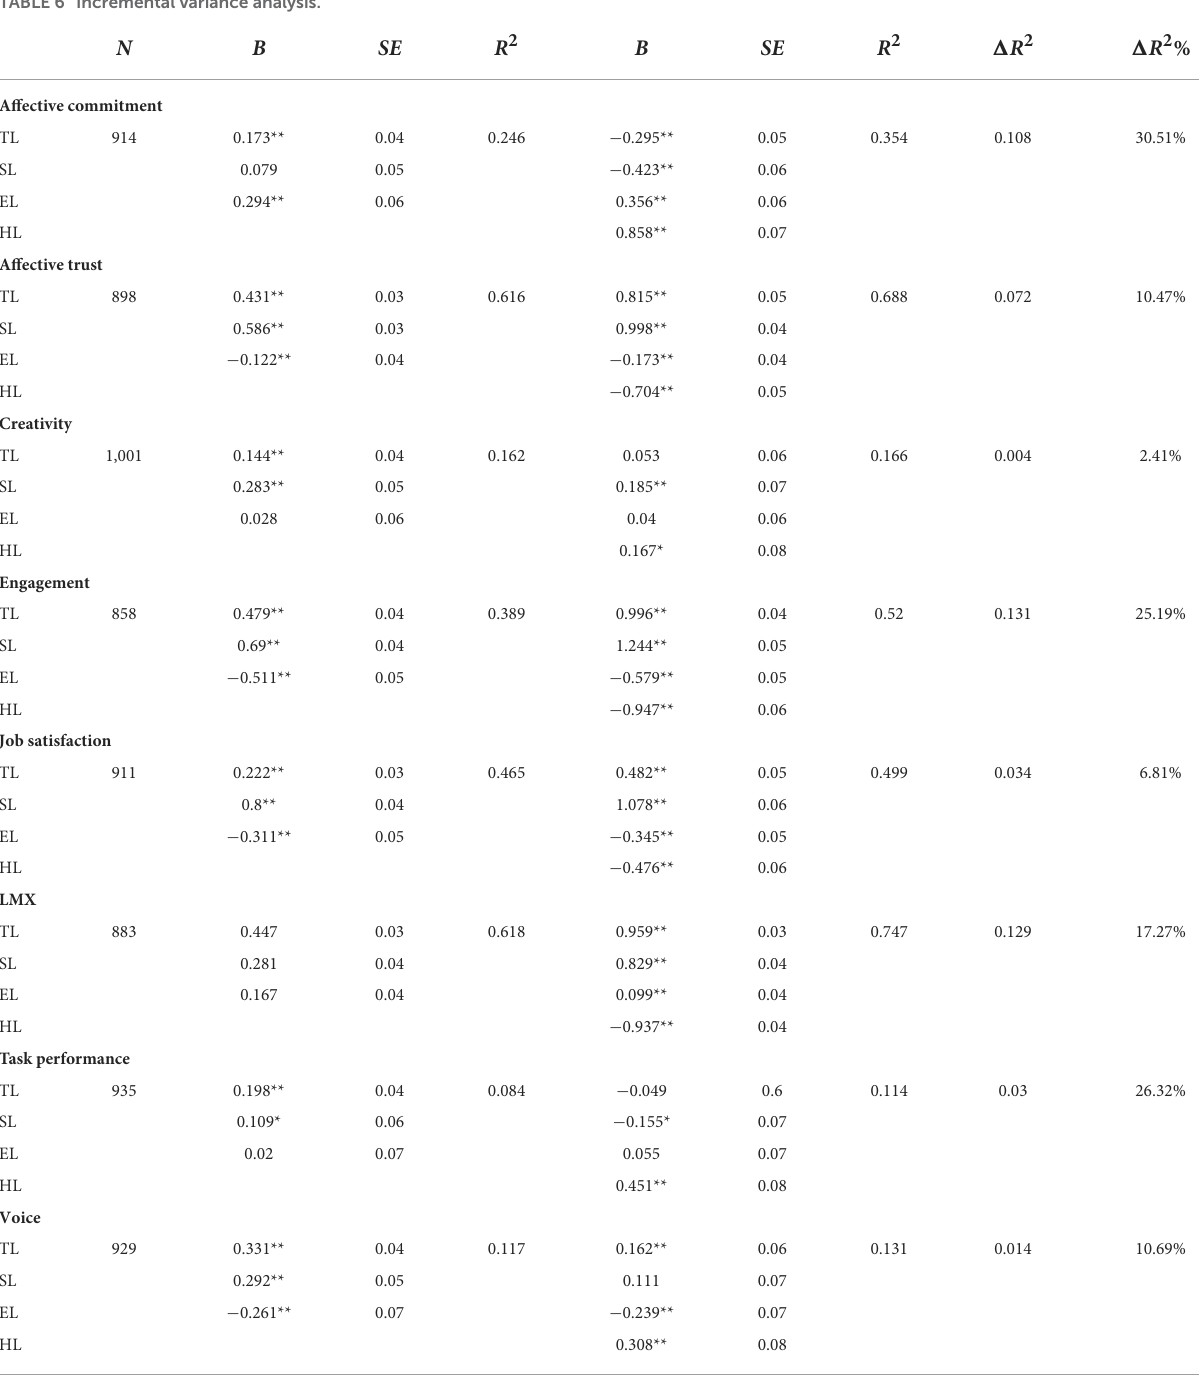
TABLE 6 Incremental variance